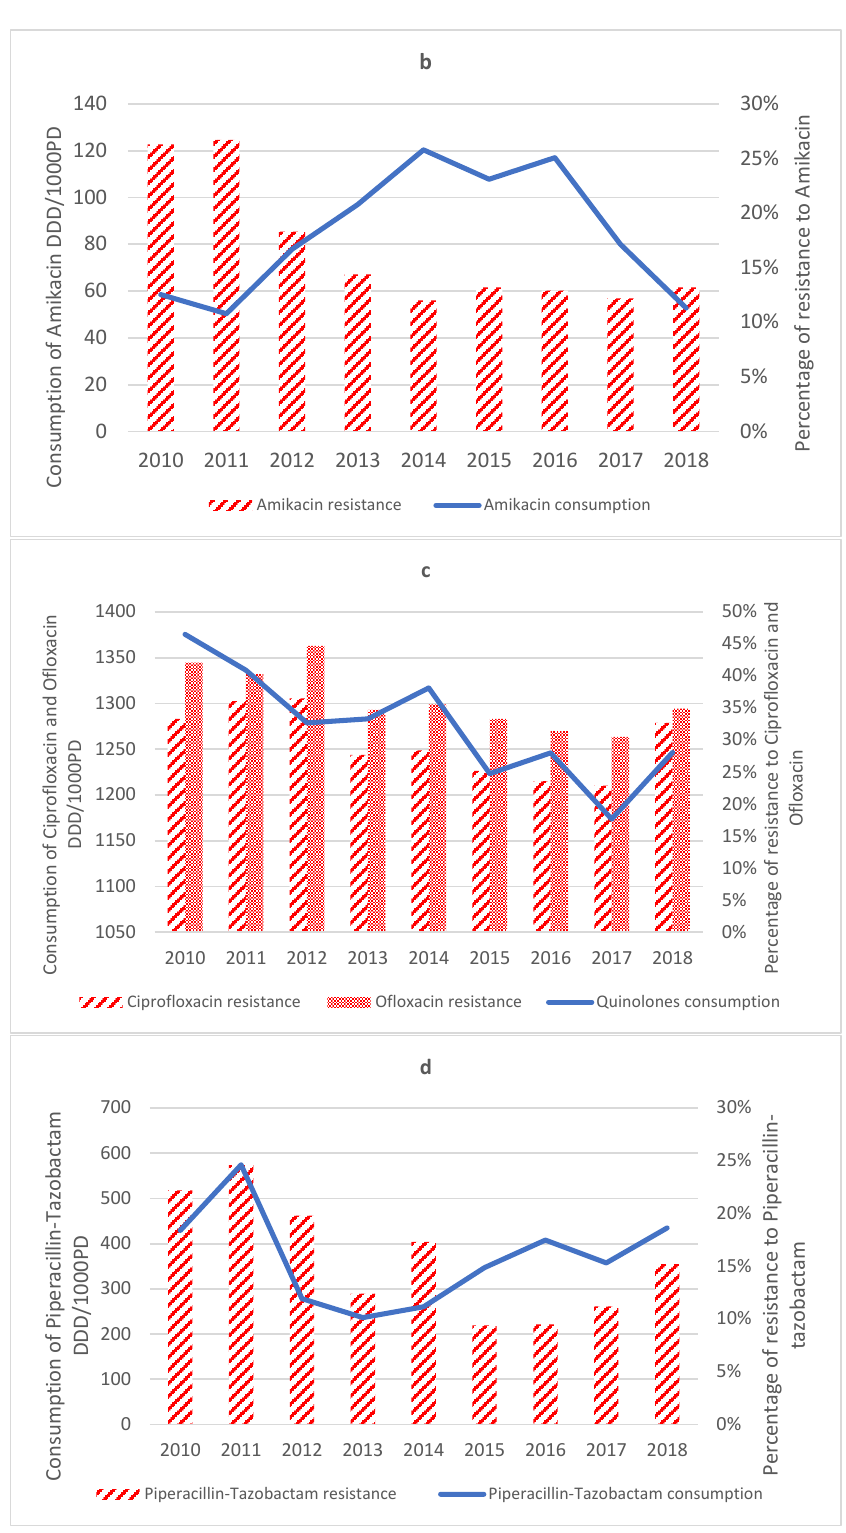
Figure 3. Consumption of antibiotics DDD/1000 PD vs. Percentage of PAE resistance to those antibiotics. ( a ) Consumption of Cefepime and Ceftazidime DDD/1000PD vs. Percentage of PAE resistance to Cefepime and Ceftazidime; ( b ) Consumption of Amikacin DDD/1000PD vs. Percentage of PAE resistance to Amikacin; ( c ) Consumption of Ciprofloxacin and Ofloxacin DDD/1000PD vs. Percentage of PAE resistance to Ciprofloxacin and Ofloxacin; ( d ) Consumption of Piperacillin– Tazobactam DDD/1000PD vs. Percentage of PAE resistance to